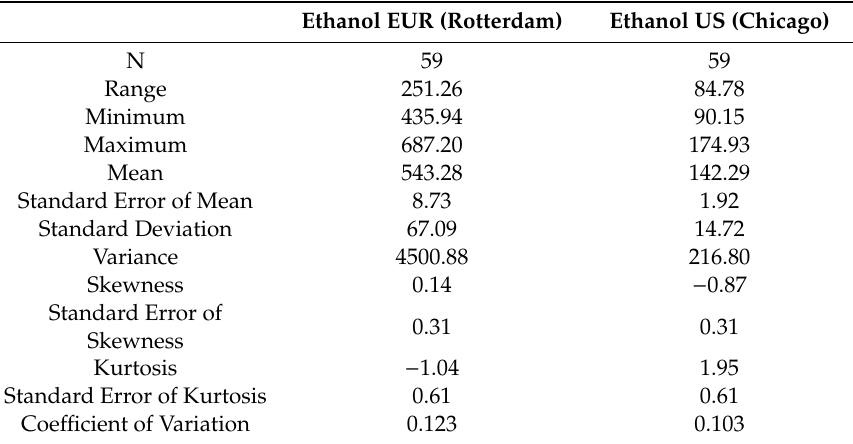
Table 2. Descriptive statistics of the price datasets.